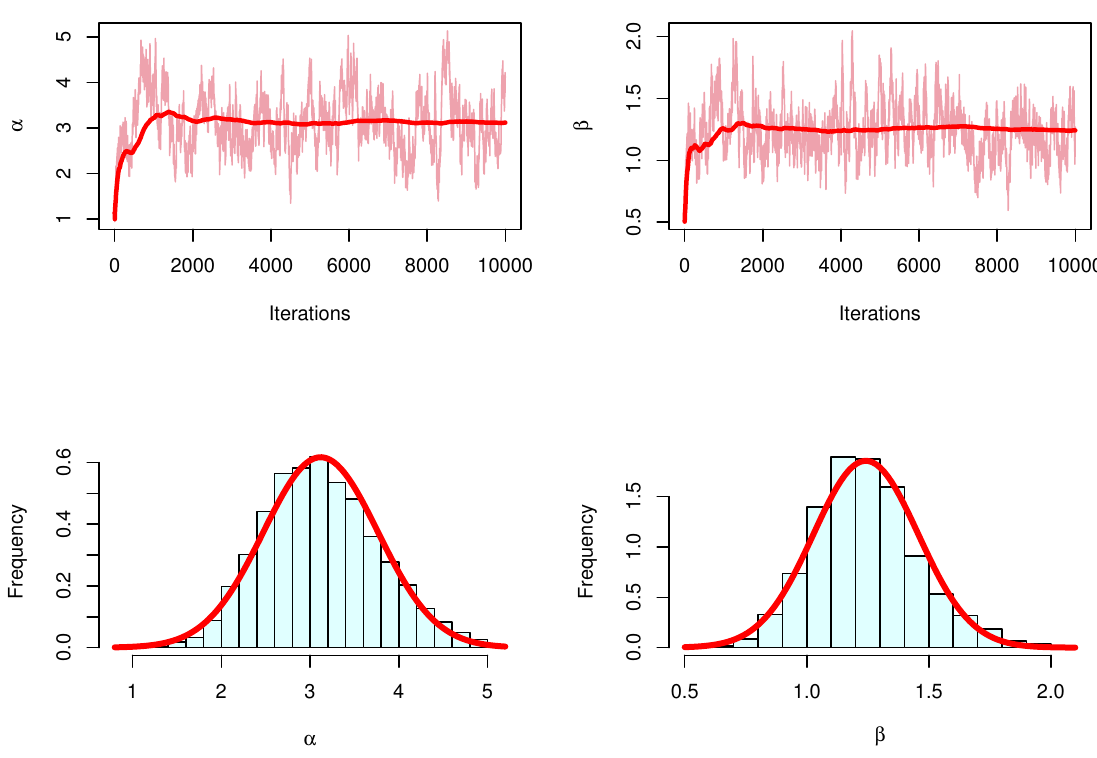
Figure 10. Trace and posterior density with normal curve for MCMC results for data